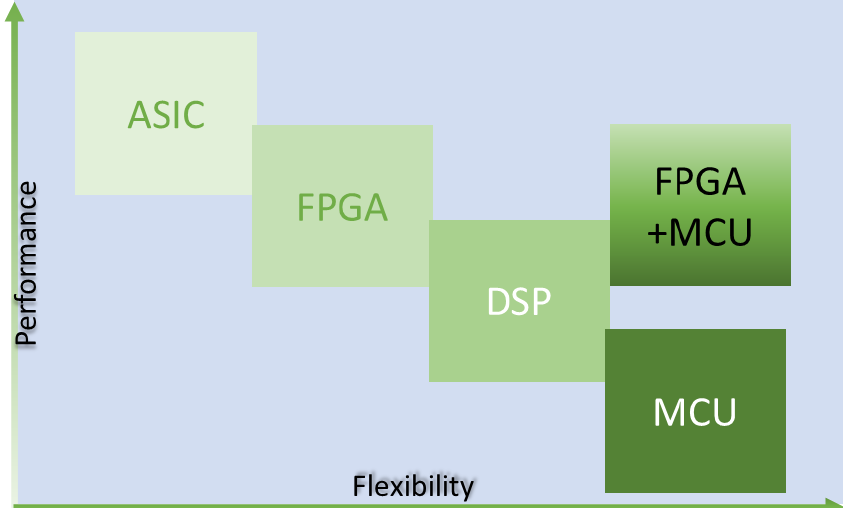
Figure 3. Different processing platforms (adapted from [5]).